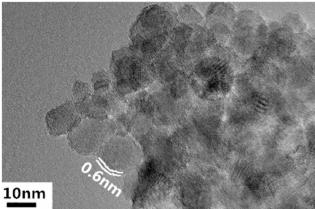
Figure 1. Transmission electron microscopy (TEM) image of TiO 2 nanoparticles.